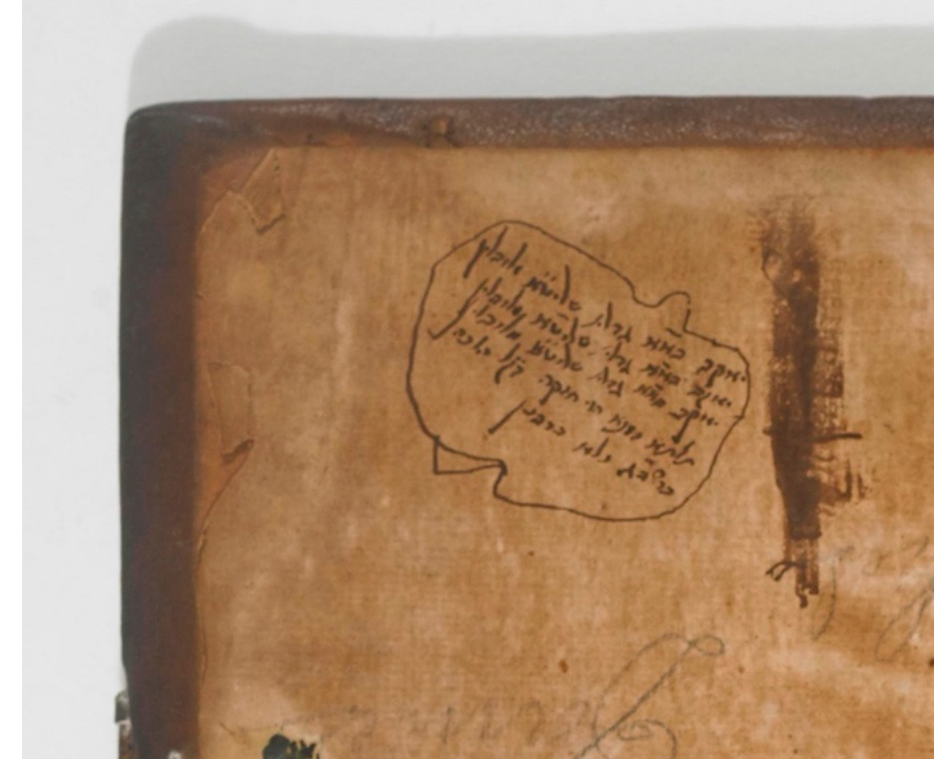
Figure 33. Sefer olat tamid, with name of owner; Marsh’s Library C.3.1.18.